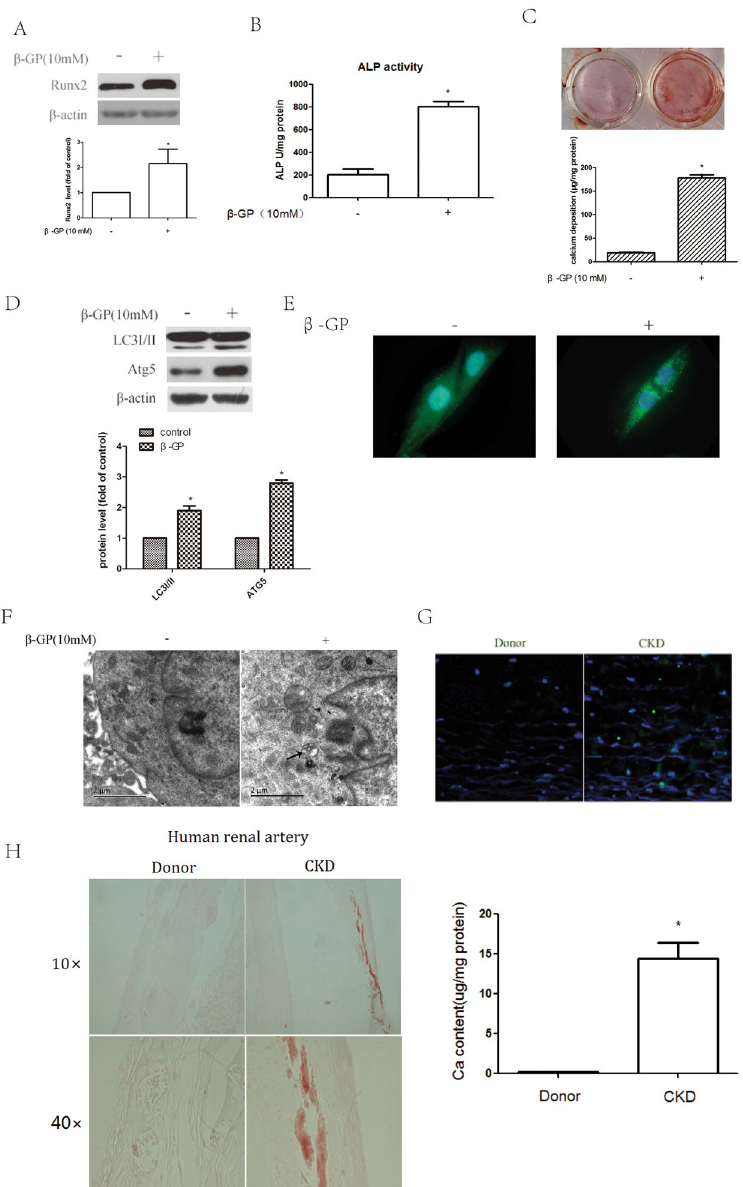
Figure 1. Autophagy is increased during the calcification of VSMCs and in calcified arteries. ( A ) Western blot analysis of Runx2 levels in VSMCs treated with 10 mM β -GP for 72 h. ( B ) Effect of β -GP on ALP activity. VSMCs were cultured with β -GP for 72 h; ALP activity was measured using an ALP kit. * p < 0.01 compared with the cells treated with vehicle (n = 5). ( C ) Effect of β -GP on calcium deposition. VSMCs were treated with β -GP for 12 days. A representative plate view of the Alizarin Red S staining is shown. Quantification of calcium levels using the O-cresolphthalein complexone method. * p < 0.01 compared with the cells treated with vehicle (n = 5). ( D ) Western blot analysis of LC3I/II and Atg5 levels in VSMCs treated with 10 mM β -GP for 72 h (n = 5). ( E ) Confocal microscopy of green fluorescent proteins (GFP) in VSMCs transiently transfected with GFP-LC3 plasmids cultured for 48 h and then treated with β -GP for 72 h. Autophagosomes are indicated by the fluorescent puncta. ( F ) VSMCs were incubated with β -GP for 72 h and then analysed by electron microscopy. A representative image is shown. Autophagosomal vacuoles containing organelle remnants are highlighted by arrows (n = 5). ( G ) Immunofluorescence analysis of LC3 puncta in the renal arterial wall from human organ donors and uremic patients during renal transplantation (n = 10). ( H ) Alizarin Red S staining was used to evaluate vascular calcification in the renal arterial wall from human organ donors and uremic patients (n = 10). ( I ) Calcium deposition in the arteries from human organ donors and uremic patients. Calcium was extracted with HCl and quantified by spectrophotometry using the O-cresolphthalein complexone method. Calcium content was measured by spectrophotometry using the O-cresolphthalein complexone method. Representative images are shown (n = 10). The data are expressed as the mean ± SD. * p < 0.01 compared with the donor